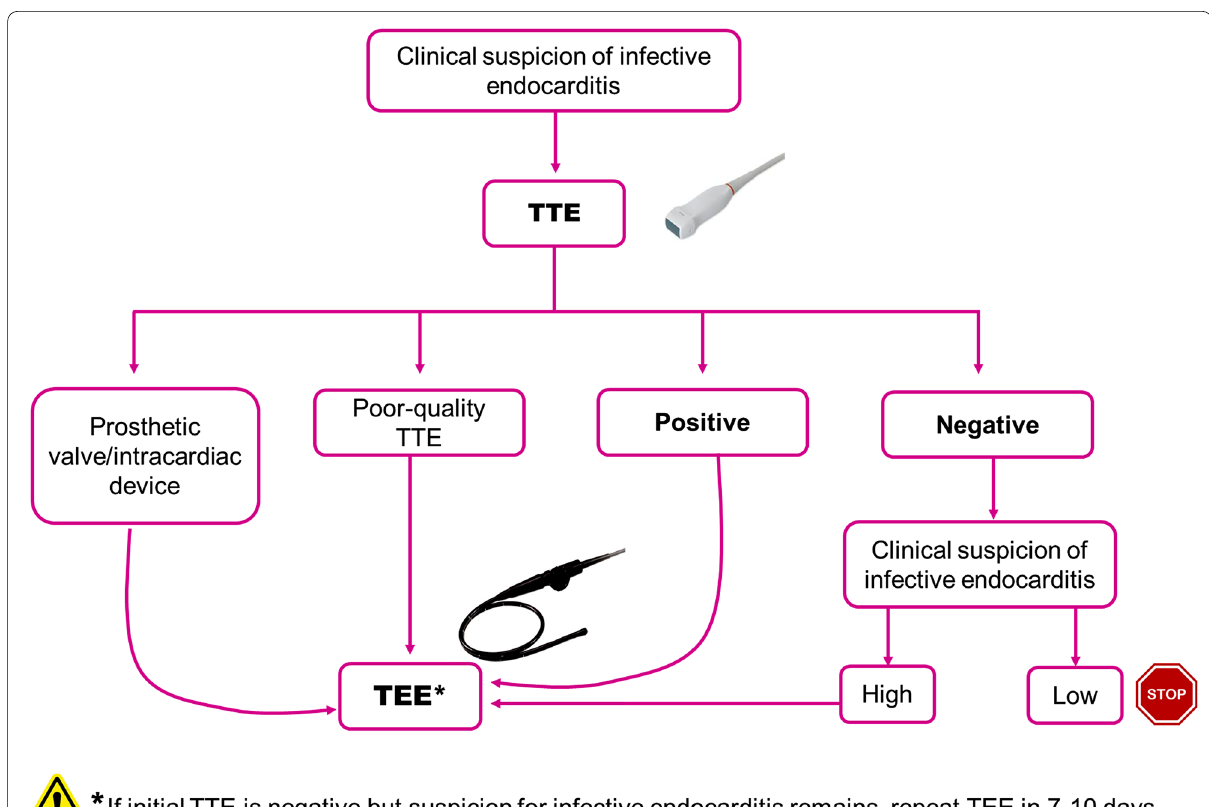
Fig. 2 Diagnostic algorithm for echocardiographic diagnosis of infective endocarditis. TTE transthoracic echocardiogram, TEE transesophagic echocardiogram. Modified from